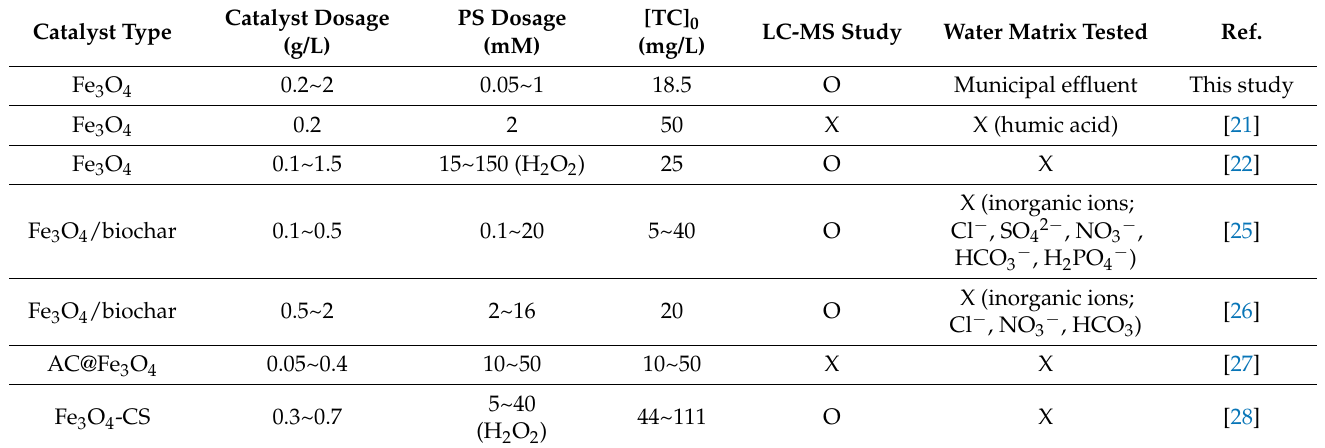
Table 1. Comparison of experimental conditions used in this research with